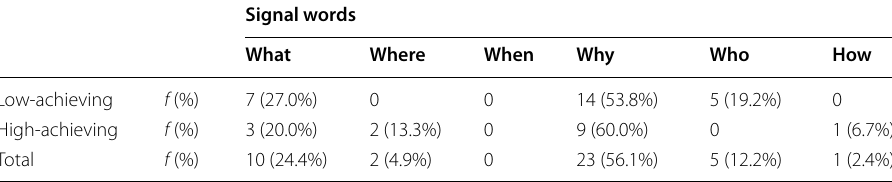
Table 3 Use of the ‘Signal Words’ procedural prompt by the low‑ and high‑achieving